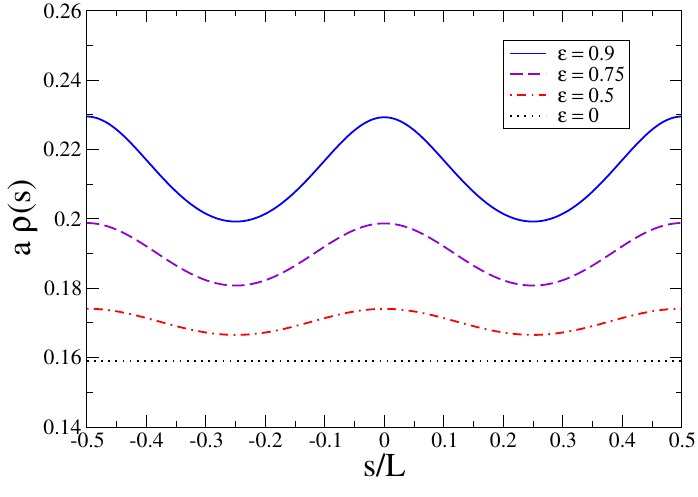
Figure 2: Probablility density ρ ( s ) of the non-interacting BEC ground state in an ellipse as a function of the arclength s , where a is the length of the major semi- axis and L = aE ( 2 π , ε ) is the perimeter of the ellipse. The curves are obtained for different values of the eccentricity ε . Here the s-wave scattering length a zero or, equivalently, the number N of particles is set to